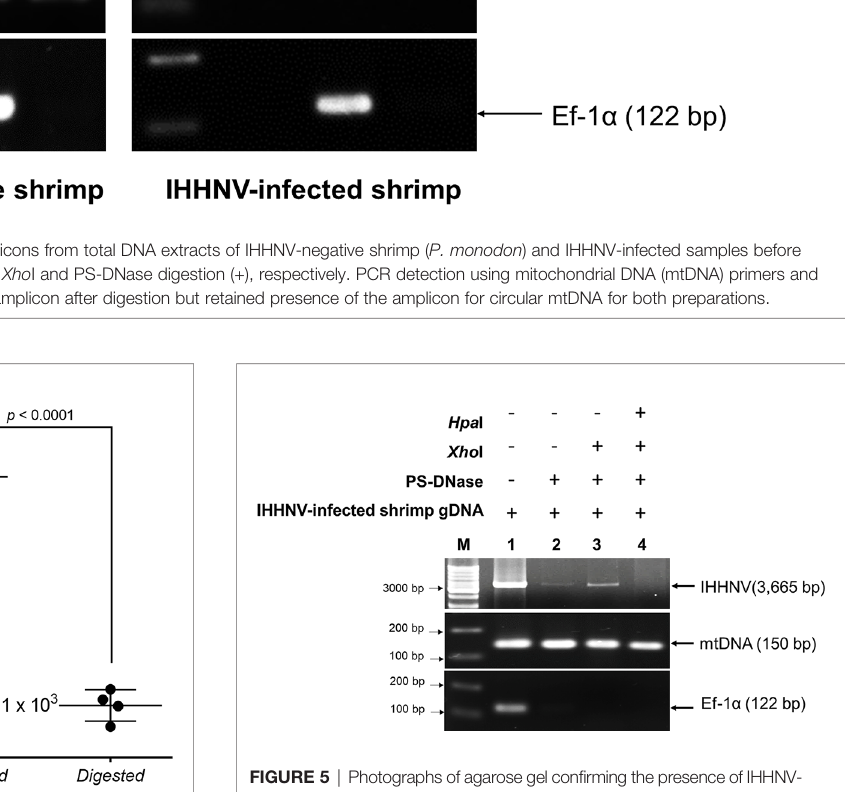
FIGURE 5 | Photographs of agarose gel con fi rming the presence of IHHNV- cvcDNA in the putative circular DNA extract. The putative circular DNA extract in